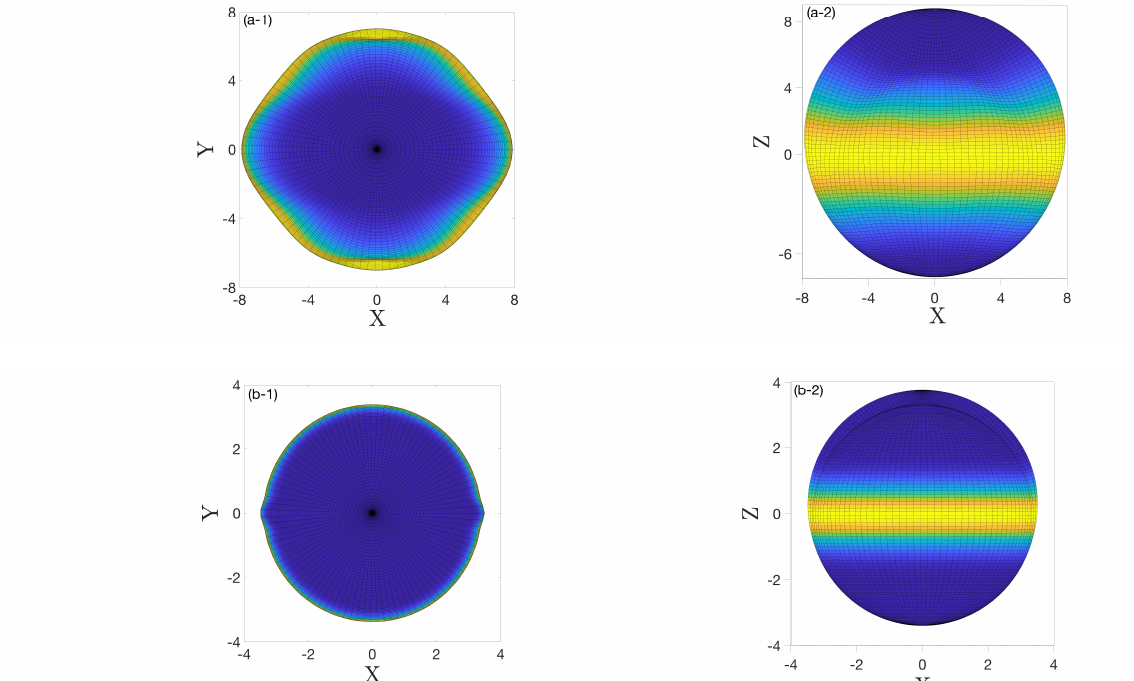
Figure 4. The asymmetric configuration of a tumor for two different choices of parameters, ( a-1 , a-2 ) { ¯ C ∞ = 1.25, η = 0.5, γ = 0.1, ¯ R = 3.37 } , the corresponding growing modes l = { 0,2,3,...,7 } , ( b-1 , b-2 ) { ¯ C ∞ = 1.5, η = 0.5, γ = 0.1, ¯ R = 5.69 } and the corresponding unstable modes l = { 0,2,3,...,30 } . The top (left) and side (right) views are shown in the figure. Colors represent the value of the z component of the radius; yellow means R z =